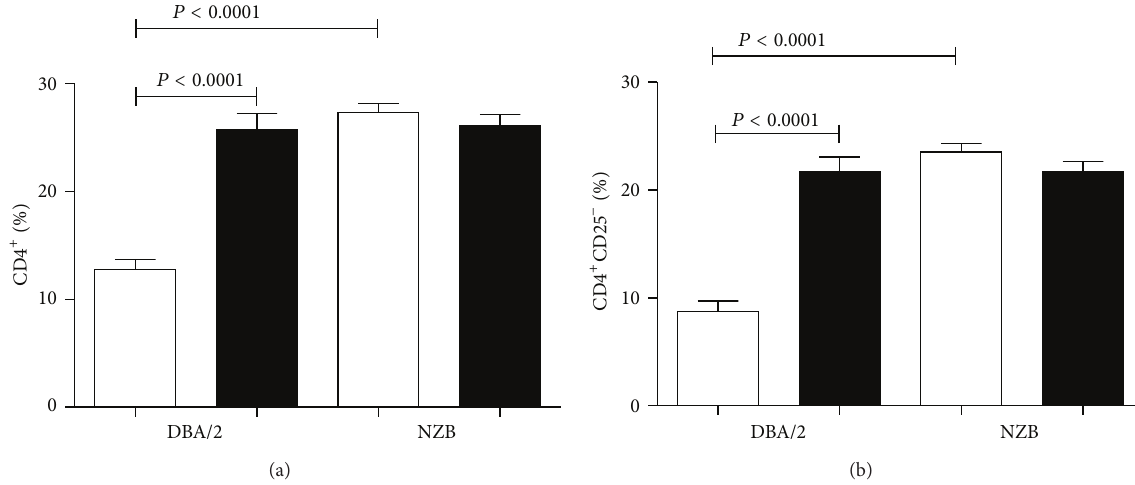
Figure 3: CD4 + T-cell expansion in mHgIA-resistant DBA/2 consists of CD25 negative cells. NZB and DBA/2 mice were exposed to PBS (white bar) or HgCl 2 (black bar) for 5 weeks. Splenocytes were then cultured in the presence of PMA/ionomycin and analyzed for percent CD4 + T cells (a) and CD4 + CD25 − T cells (b). Percentages represent cells in total spleen cells. 𝑛 = 4